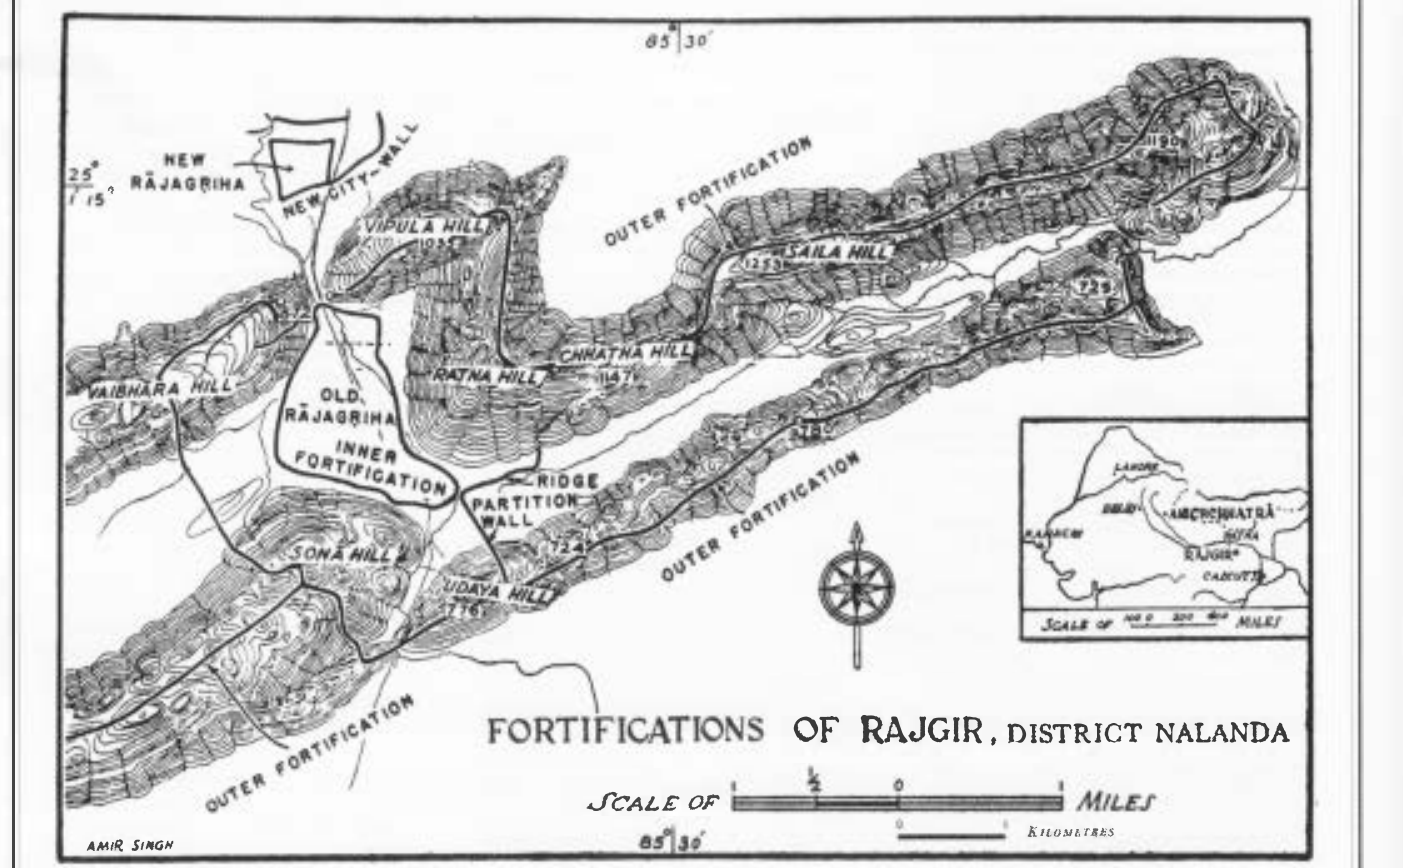
Figure 2 Sketch map of Old and New Rajgir, from the guide to Rajgir published in 1958 by the Archaeological Survey of India (from M. Kureishi A. Ghosh, Rajgir (Delhi: Archaeological Survey of India, &